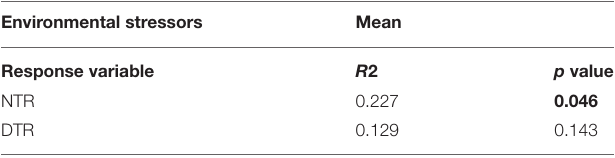
TABLE 4 | Relationships between temperature range parameters (response variables) and mean environmental stressors of the garden within 500m.